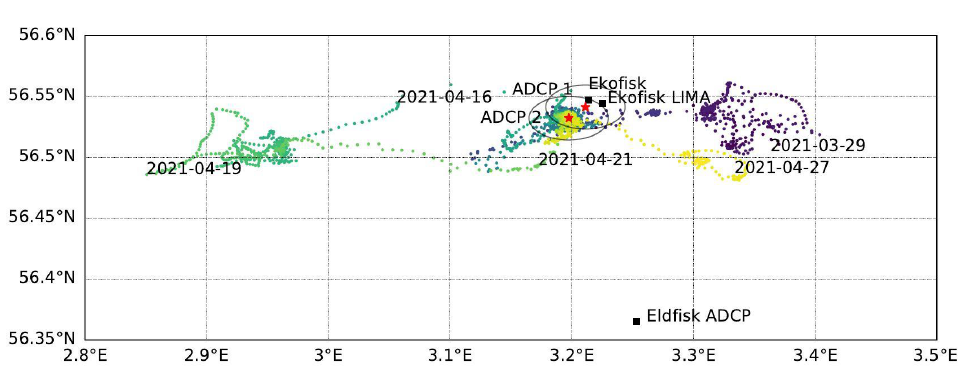
Figure 8. SB location during the Ekofisk measurement period in April 2021. The time is color-coded (starting at the end of March in purple, turning blue and green with time, and ending in yellow by the end of April). The locations of the moored ADCPs (red stars) and the Ekofisk platforms are marked for reference. Grey circles denote an approx. 2km radius around the